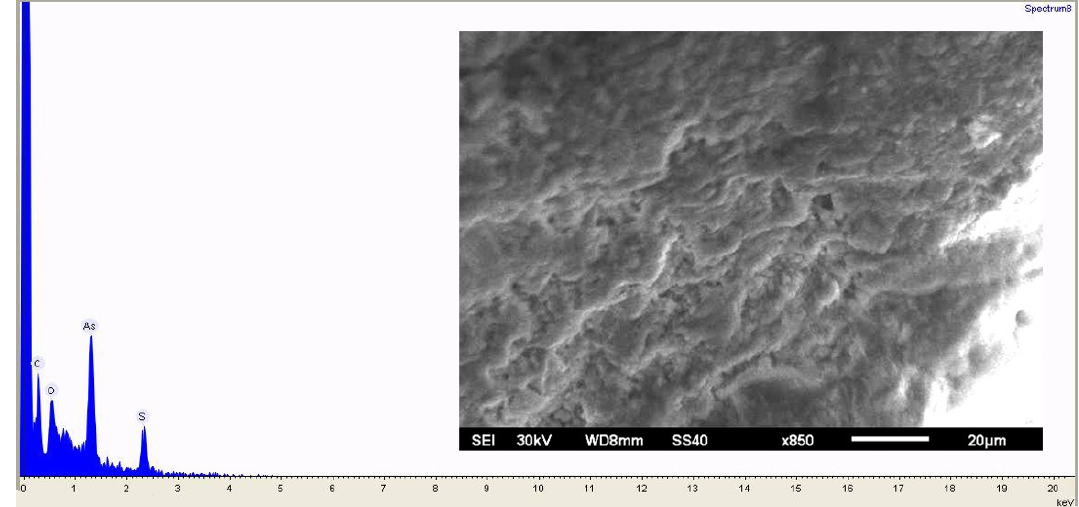
Figure 4. SEM image of the sample D2 and EDX spectrum. Elements of As and S were identified and confirm the Raman results, which revealed the presence of orpiment (As 2 S 3 ).